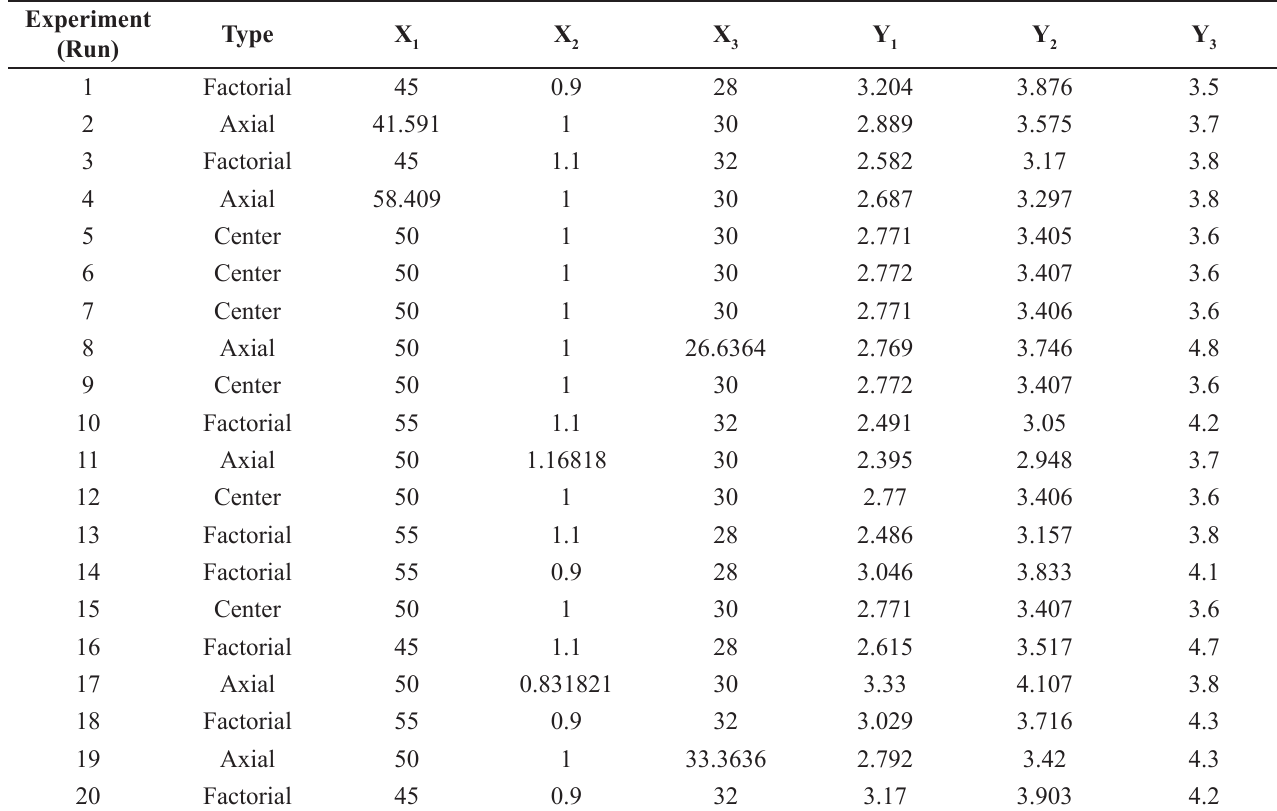
TABLE II - Coded values for factor level and observed responses in CCD for 20 analytical trials